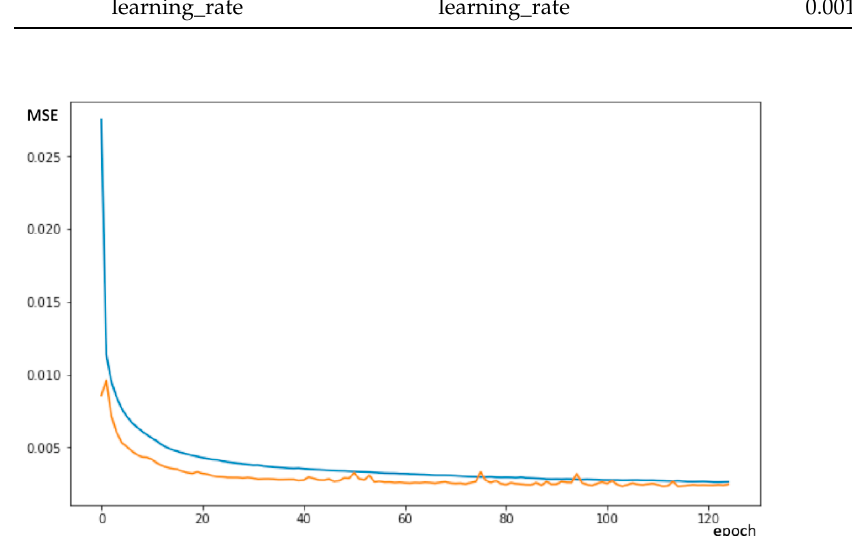
Figure 10. Overall test rResult against training result. X axis = label, Y axis = predicted value, blue dot = training result, orange dot = test result.